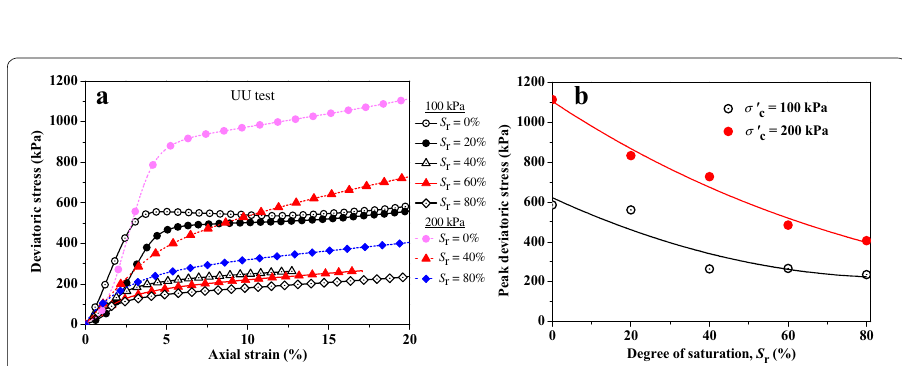
Fig. 11 Response of silty-sand soils subjected to UU tests subjected to different confining pressures and degree of saturation a stress–strain response, b peak deviator stress versus S